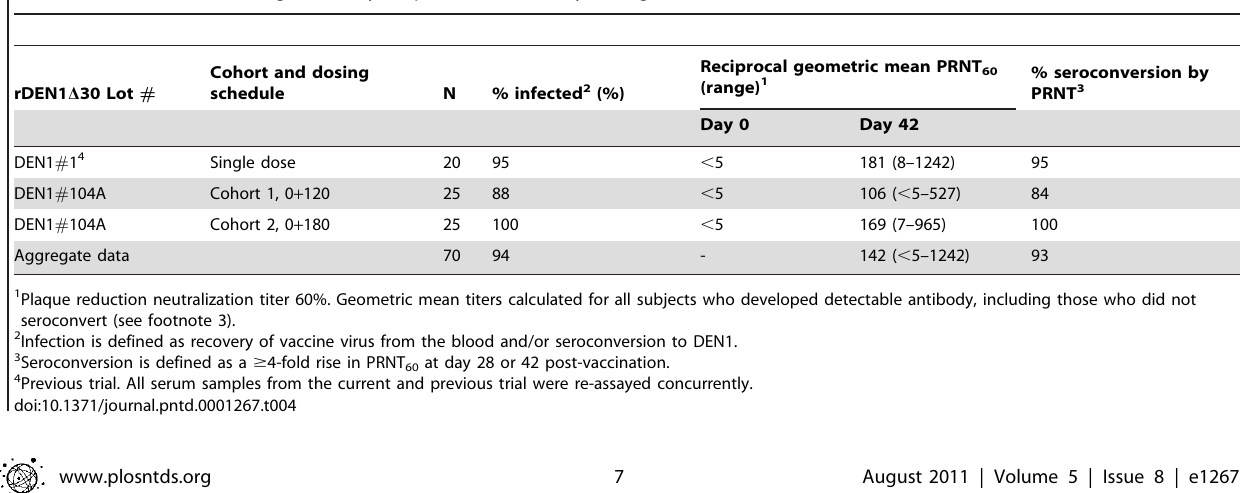
Table 4. Serum neutralizing antibody response induced by a single 10 3 PFU dose of rDEN1 D 30.